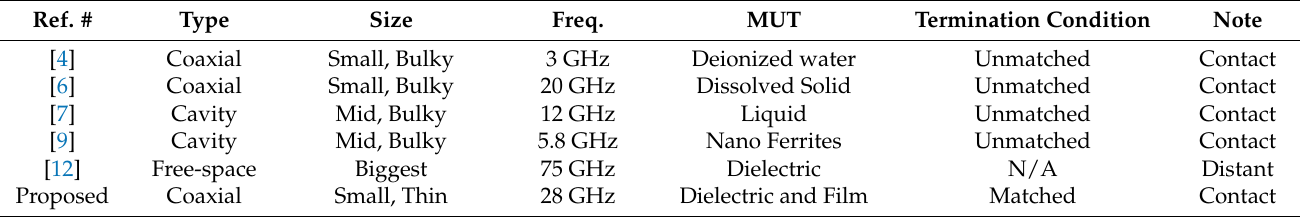
Table 3. Comparison of the proposed method with the schemes from the